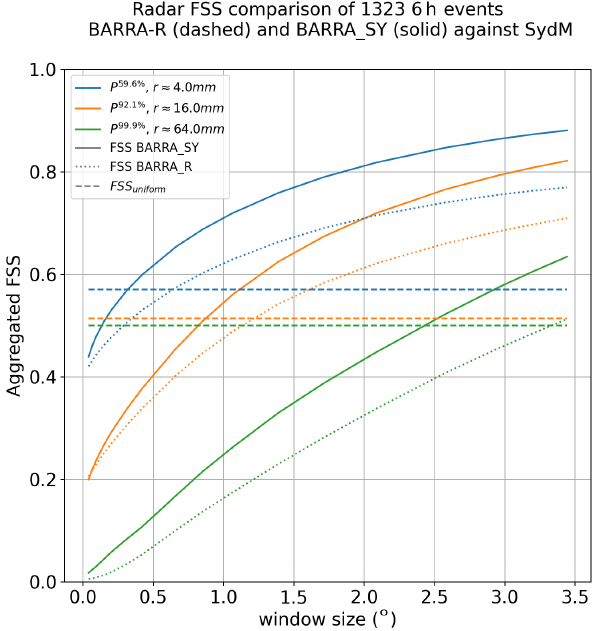
Figure 10. Aggregated FSS across 1323 6h storm events as a func- tion of neighbourhood distance (degrees) for 6h rainfall above three percentile thresholds (distinguished by colours, percentile values, and observed amount in mm). The solid curves indicate the score for BARRA-SY, dotted curves for BARRA-R, and the dashed hor- izontal lines the uniform score (FSS uniform ) for each threshold as specified by Roberts and Lean